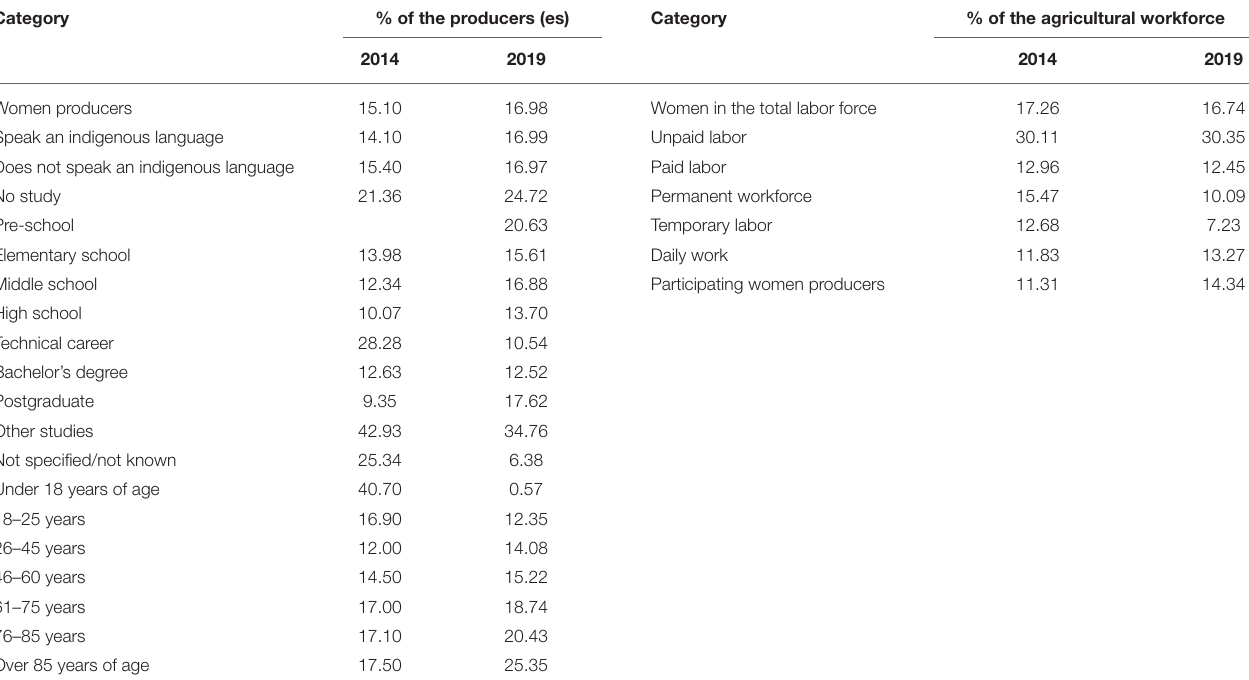
TABLE 2 | Rural women farmers’ socioeconomic status. Category